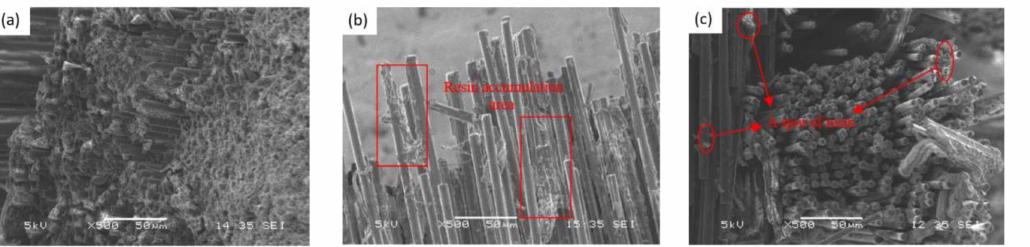
Figure 11. Three-point flexural microfracture of composite (500 × ). ( a ) 26.6% CF, ( b ) 64.9% CF, ( c ) 76.4% CF.